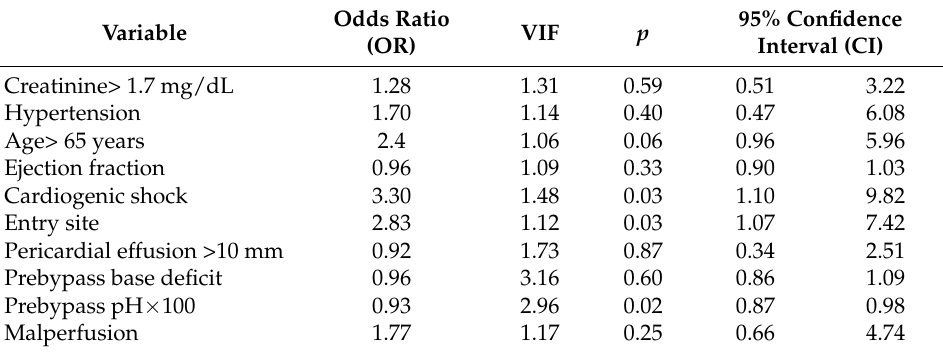
Table 2. Multivariate risk analysis for early